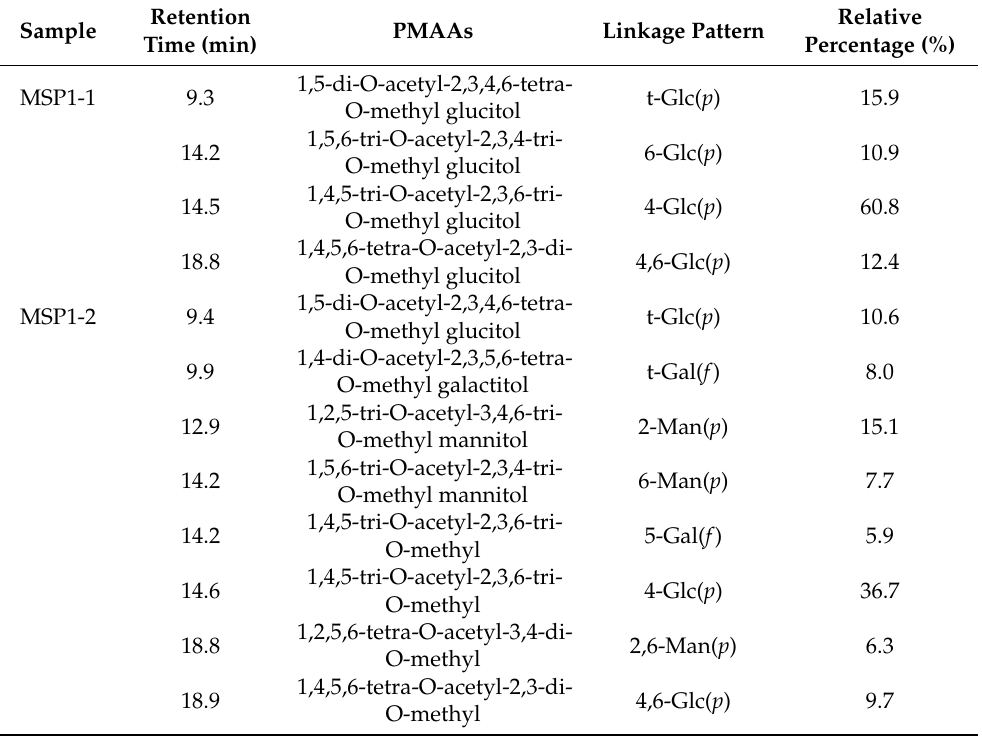
Table 1. Glycosidic linkage type composition of MSP1-1 and MSP1-2 based on gas chromatography–mass spectrometry (GC-MS) results.